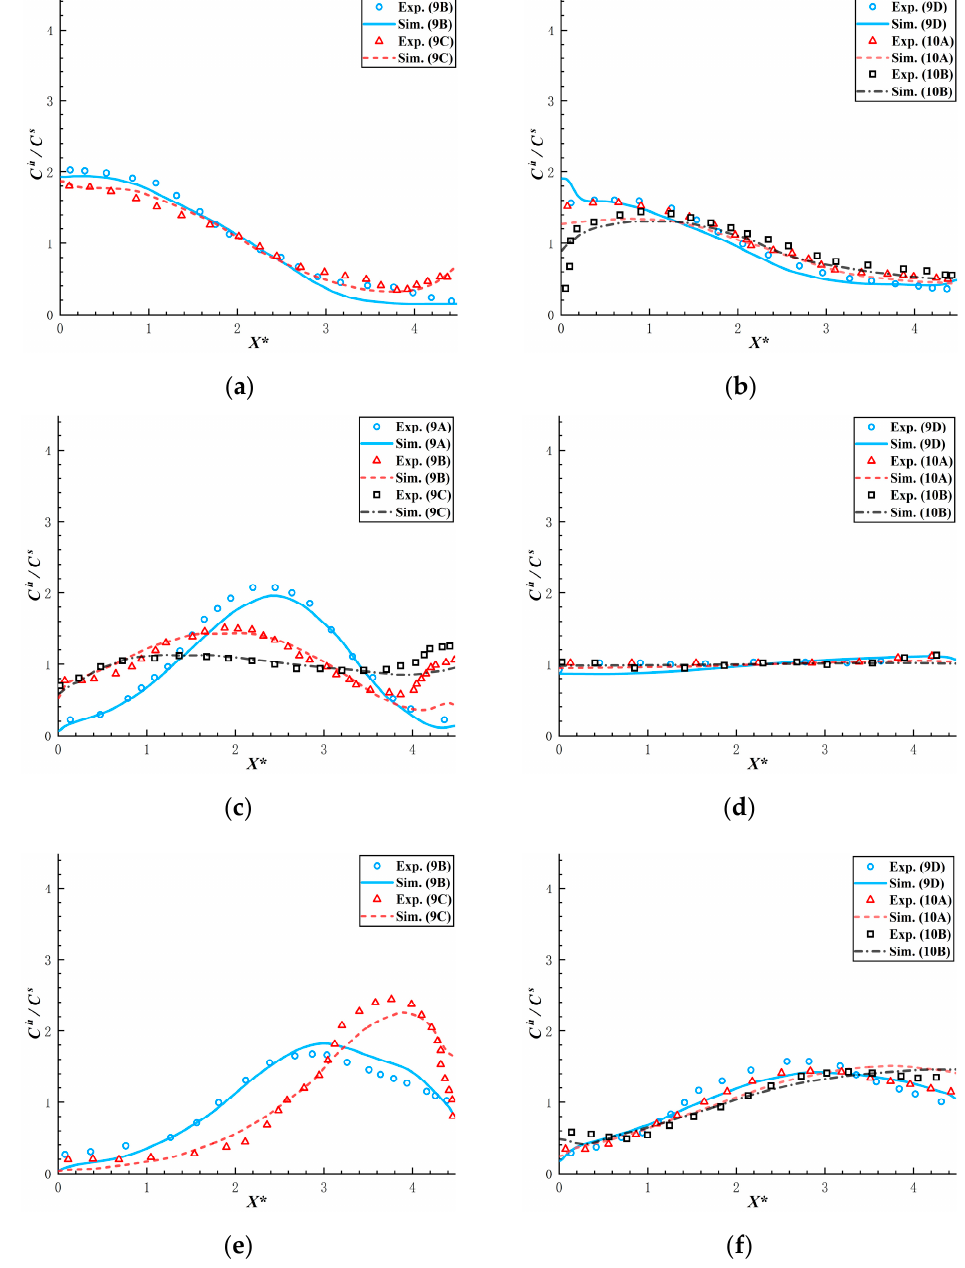
Figure 6. Comparison between simulations and measurements in depth-averaged concentration of the scalar C h , made non-dimensional with local mean concentration C s : ( a , b ) C1 scenario; ( c , d ) C2 scenario; ( e , f ) and C3 scenario.